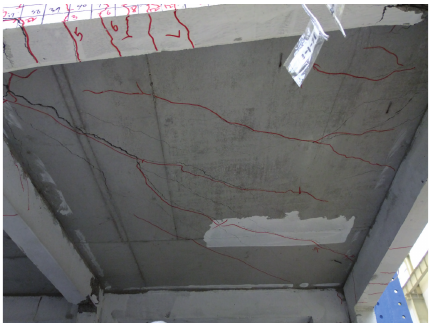
Figure 9: Crack on bottom surface of